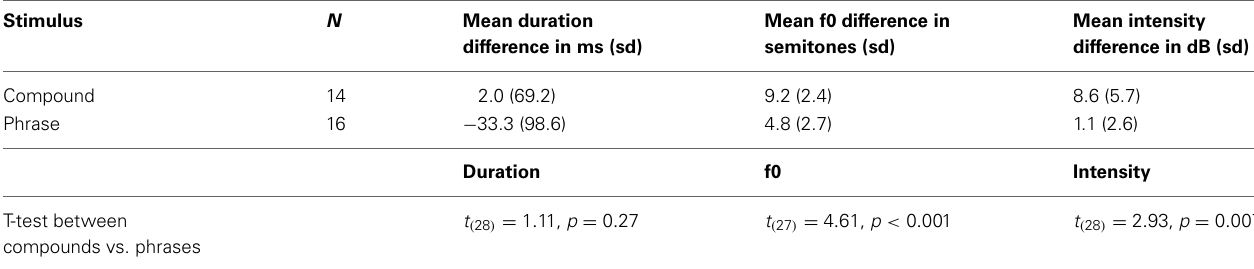
Table 2 | The differences between the cues for word stress in first and second stressed syllables in compound/phrase utterances.